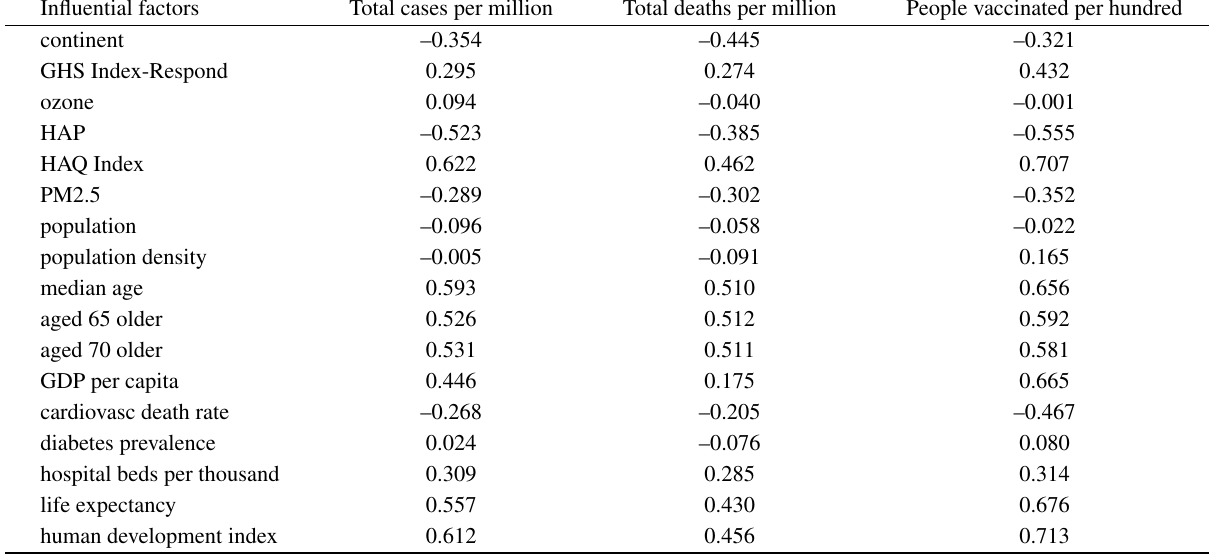
Table 2A Pearson’s correlation coefficients for influential factors that may contribute to the COVID-19.